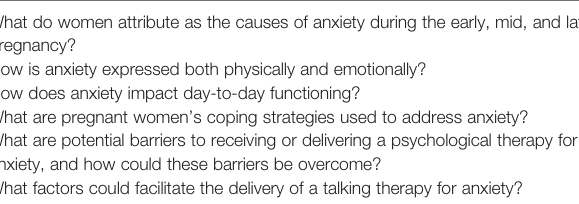
TABLE 1 | Areas included in the topic